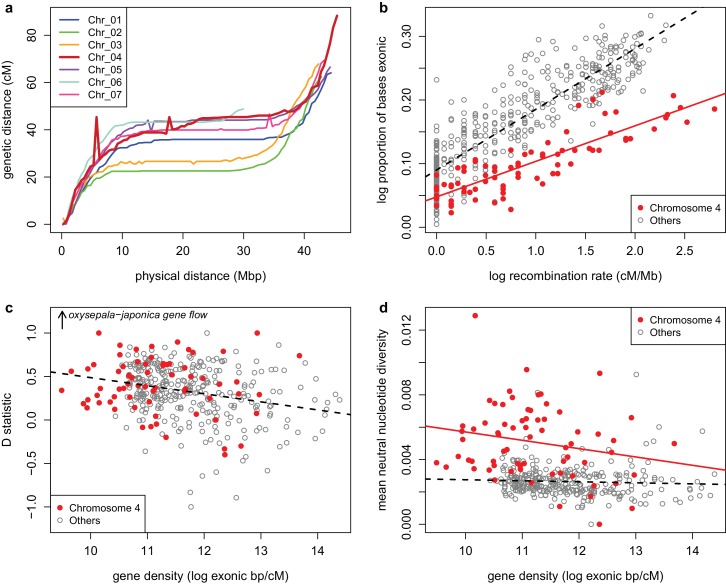
Recombination and selection on chromosome four (a) Physical vs.genetic distance for all chromosomes calculated in an A. formosa x A. pubescens mapping population. High nucleotide diversity on chromosome four was also observed in parental plants of this population (Figure 7—figure supplement 1. (b) Relationship between gene density (proportion exonic) and recombination rate (main effect p-value < 2 x 10-16, chromosome four effect p-value < 2 x 10-16, interaction p-value < 1.936 x 10-11, adjusted R2 = 0.8045). (c) Relationship between gene density and D statistic for A. oxysepala and A. japonica gene flow. (d) Relationship between gene density and mean neutral nucleotide diversity. Figure 7—source data 1.10.7554/eLife.36426.021Figure 7—source data 1.(Physical and genetic distance for A.formosa x A.pubescens markers).